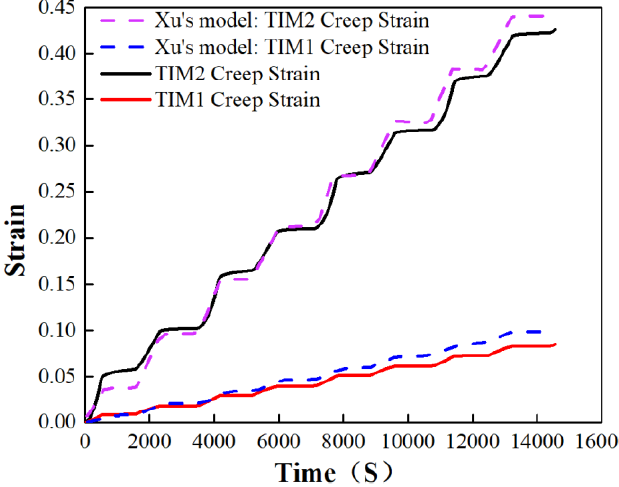
Figure 5: Accumulated creep